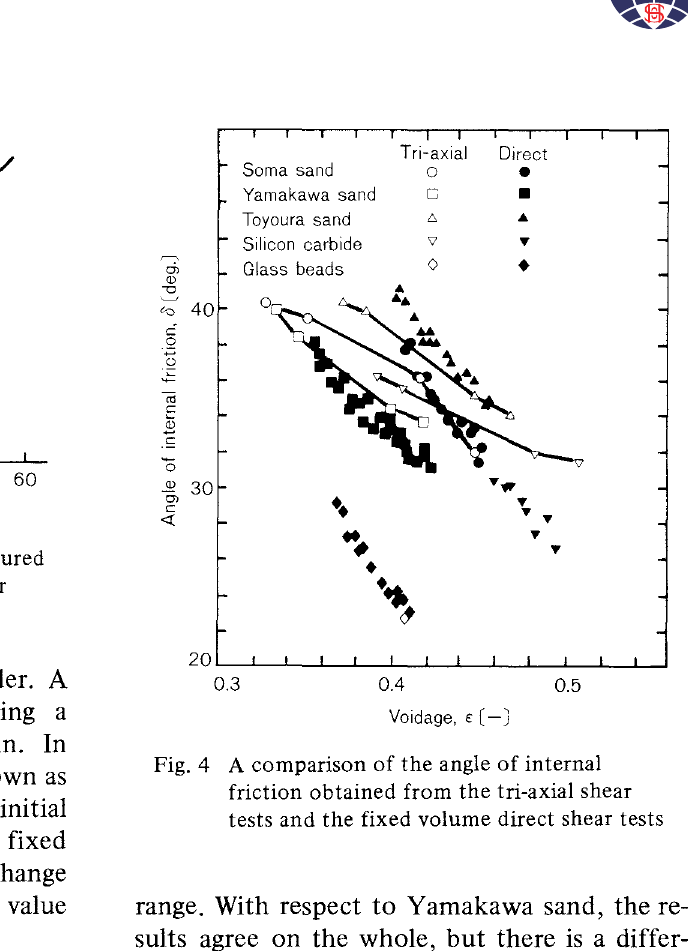
range. With respect to Yamakawa sand, there ence of up to 3° in the loosely packed